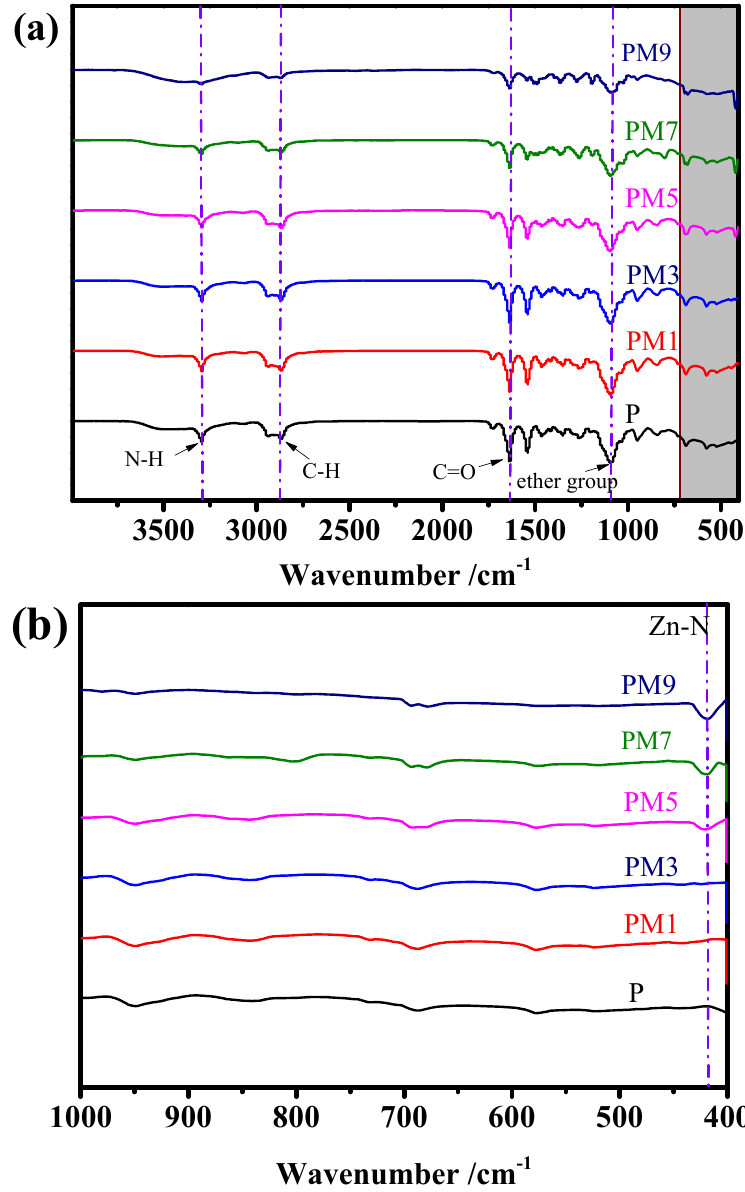
Figure 7. Fourier transform infrared spectroscopy patterns of P, PM1, PM3, PM5, PM7, and PM9. ( a ) 405–3990 cm − 1 and ( b ) 400–1000 cm − 1 . ( a ) 405–3990 cm − 1 and ( b ) 400–1000 cm − 1